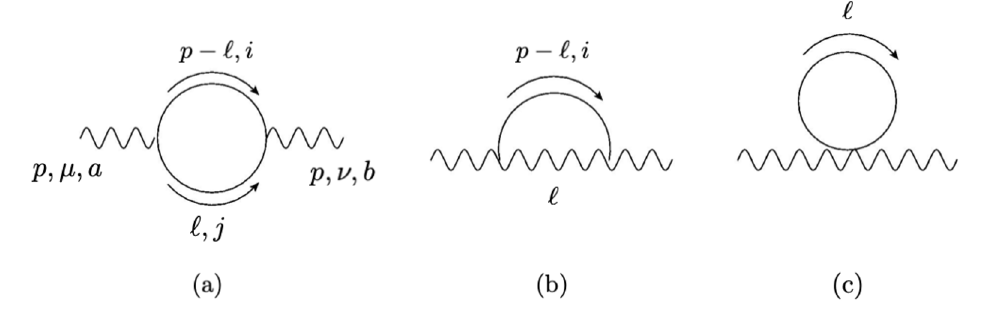
Figure 7 . Feynman diagrams for the self-energy of the gauge bosons from the scalar particles. (a) contains a divergence, (b) is finite, and (c) does not contribute to the field-strength